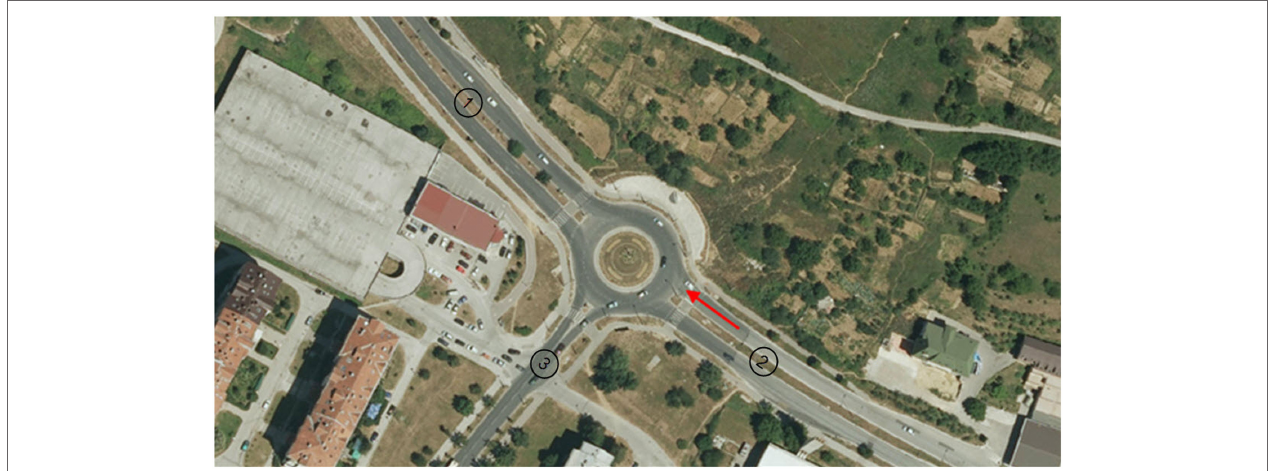
FIGURE 3 | Layout of analyzed two-lane roundabout in Sarajevo, Bosnia and Herzegovina.